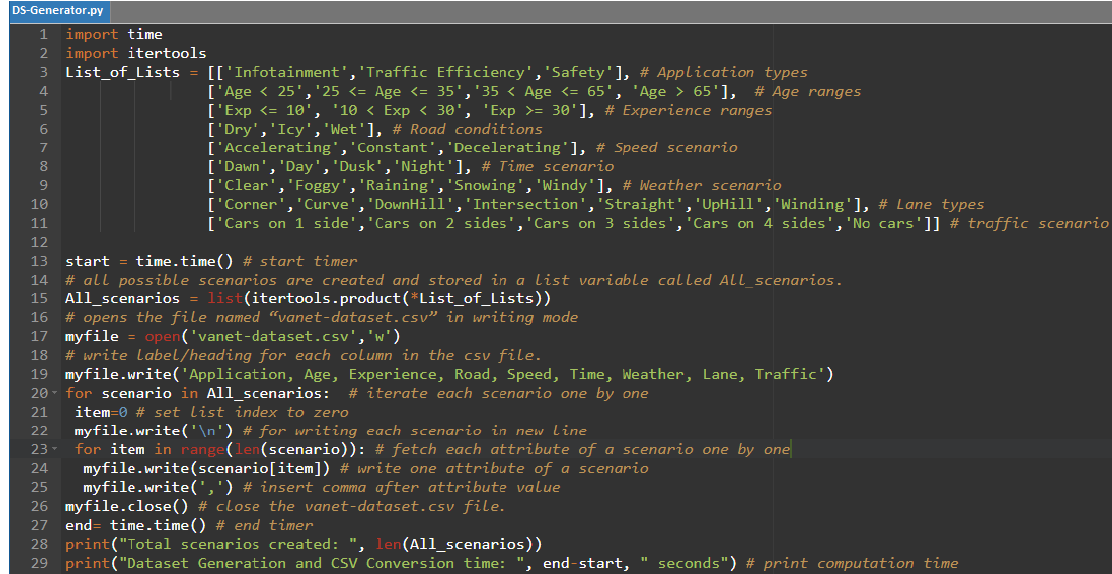
Figure 11. Python code for VANET DataSet generator.